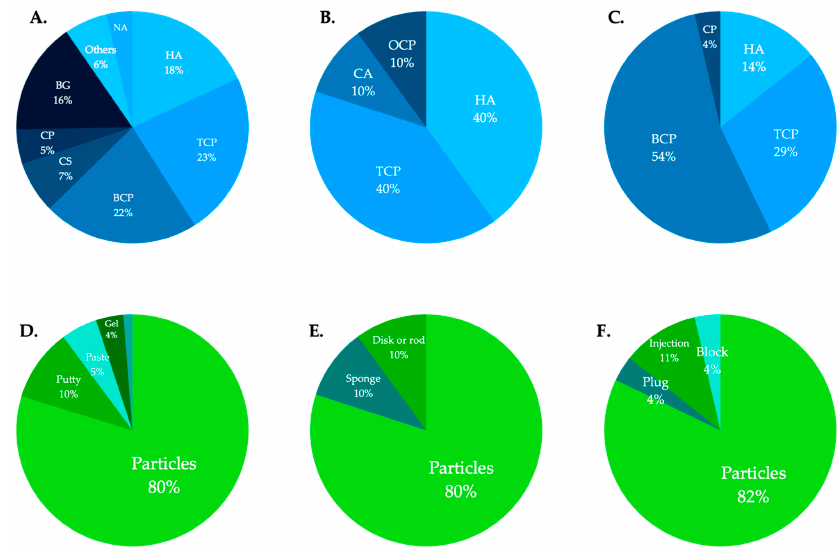
Figure 1. Dental alloplastic bone substitute products according to components and available forms commercially available in the United States ( A and D ), Japan ( B and E ), and Korea ( C and F ). HA = hydroxyapatite, TCP = tricalcium phosphate, BCP = biphasic calcium phosphate, CS = calcium sulfate, CP = calcium phosphate, BG = bioglass, CA = carbonate apatite, OCP = octacalcium phosphate.